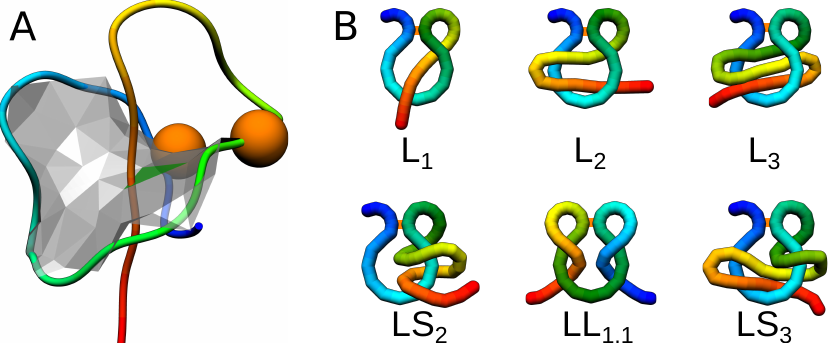
Figure 1. Complex lasso proteins.( A ) An exemplary complex lasso protein (PDB code 2mxq) with one piercing through the loop ( L 1 type). The orange beads denote the cysteine residues; ( B ) Schematic depiction of six complex lasso motifs, with the orange bar denoting the